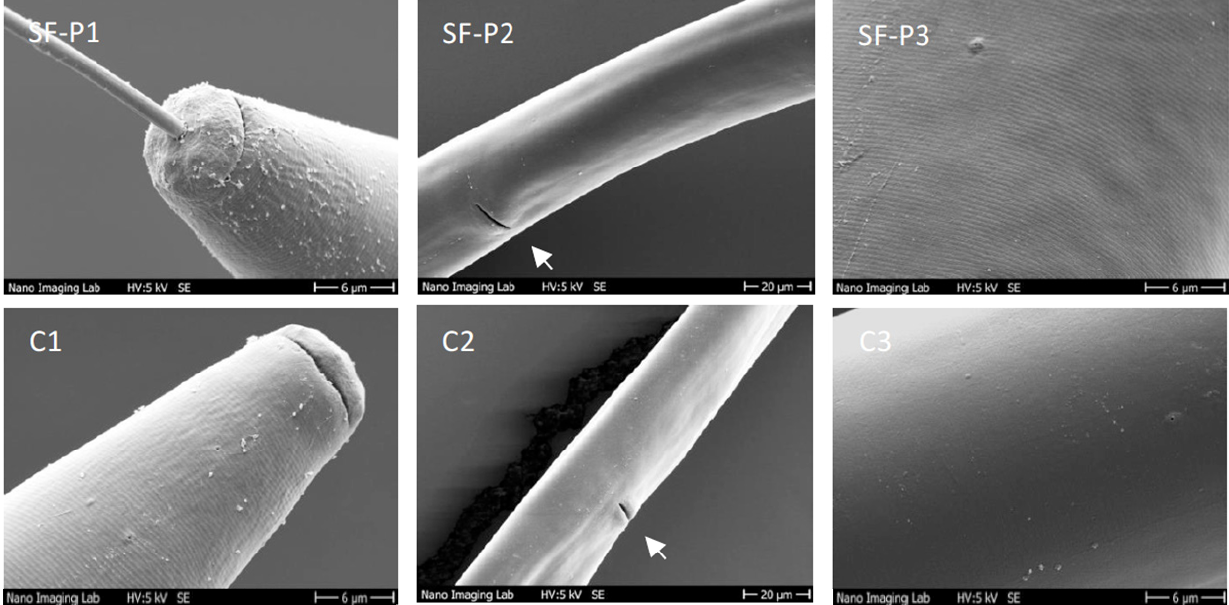
Figure 4. Observation of X. index under Scanning Electron Microscope (SEM). Observation of sexual region (arrow indicates vulva) (SF-P1/C1), cephalic region (SF-P2/C2) and cuticle surface (SF-P3/C3) of X. index , after treatment with sainfoin pellet extract at 20 g · L − 1 during 72 h (SF-P1–3) or incubation in control conditions (PBS 1%)